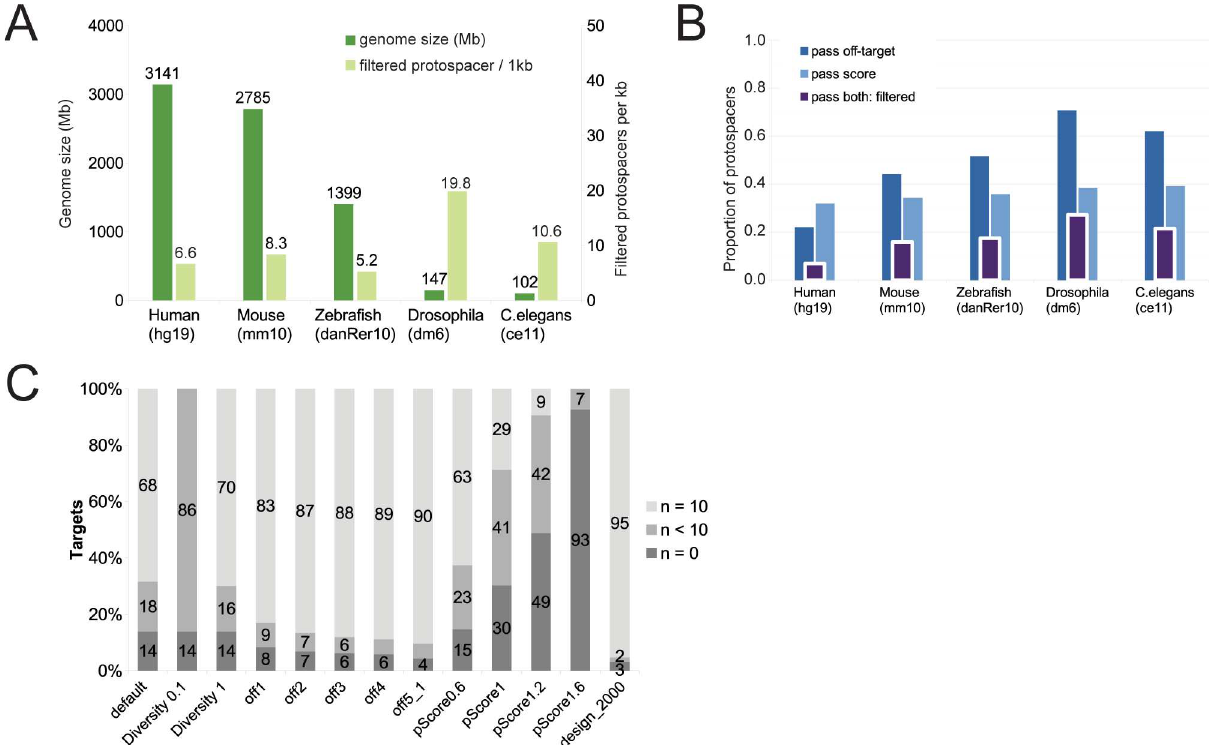
Fig 2. Benchmarking and performance. (A) Genome size and filtered protospacer density for the five speciestested. (B) The fraction of protospacers passingfilters of off-targeting, efficiencyscore, and both. The latter are definedas “filtered protospacers”, whose density is shown in (A). Data are displayedas a fraction of the total number of canonicalPAM sequencesin each genome.(C) The effect on library qualityof modifyingdesign variables. Y-axis denotes the percent of target regions, dividedby: “successful”, where n = 10 distinct sgRNA pair designsare returnedper target; “intermediate” designs,where 0 < n < 10pairs are returned;“failed” designs,where n = 0 pairs are returned. CRISPETa was run on a test set of 7000 targets (see Materialsand Methods for details). The first column representsthe run performed with default settings, and in each subsequent column one variableis modified(see Table 3 for